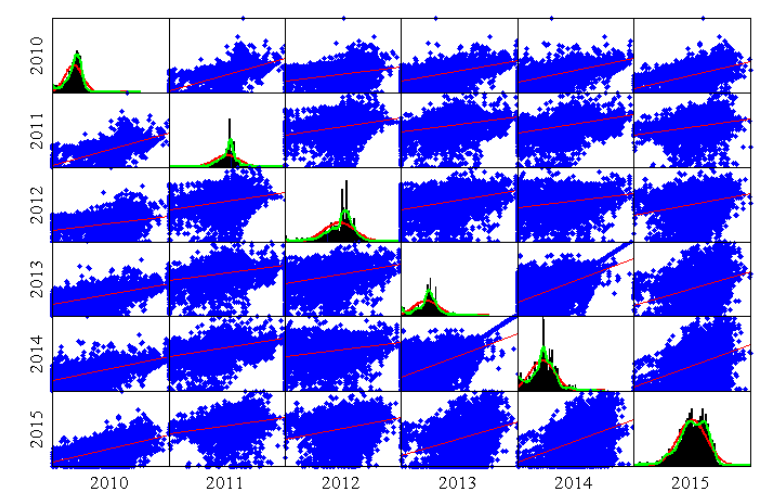
Figure 1. Scatter plot of the Spanish electricity prices of 2010, 2011, 2012, 2013, 2014 and 2015.